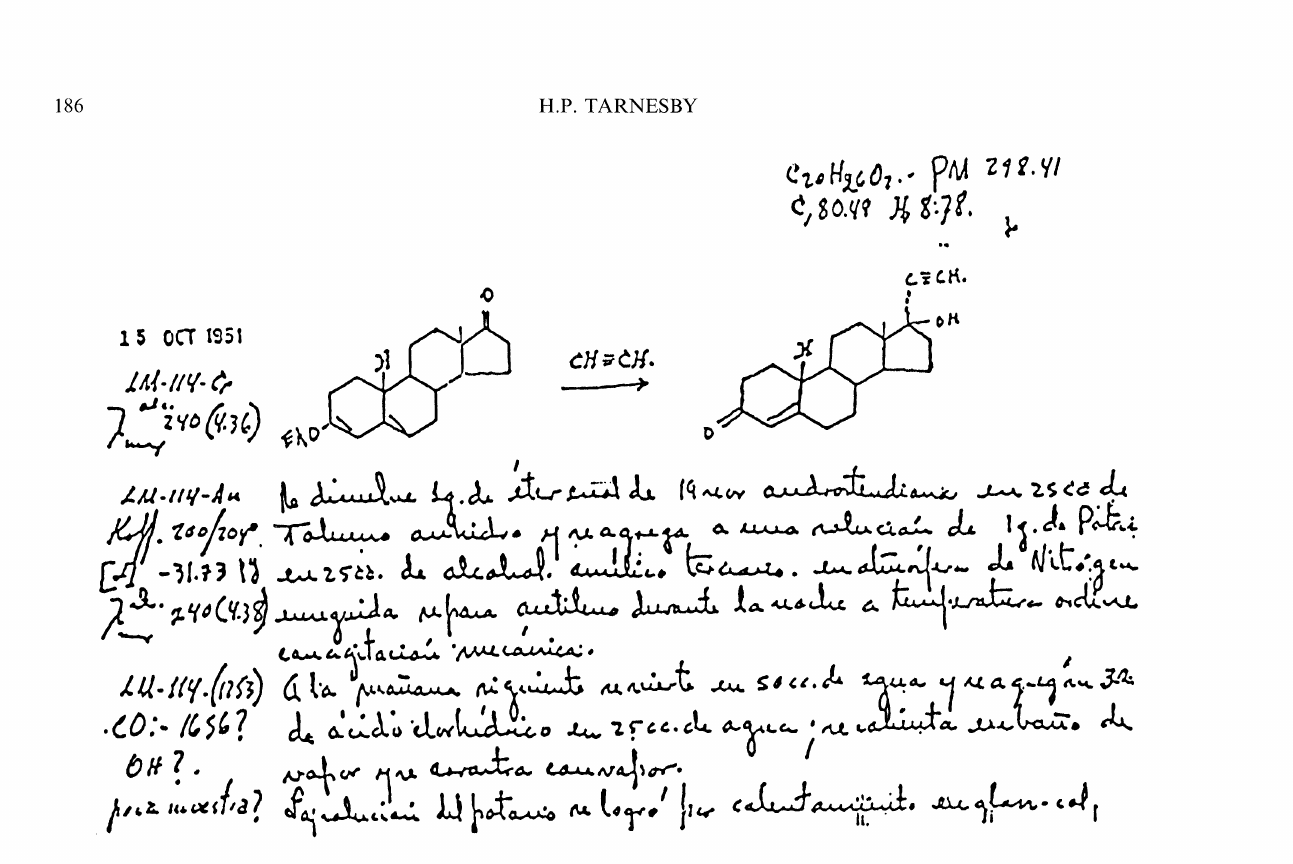
FIGURE The final step in the original synthesis of norethindrone. Facsimile of the record of October 15, 1951, from Djerassi’s laboratory where this synthesis was accomplished. The text describes the overnight (left-hand formula) reaction between enolether of androstenedione and various reagents under continuous mechanical agitation at room temperature. The text then outlines the steps to be taken the next day that are expected to result in synthesis of norethindrone (right-hand formula). (Courtesy of Syntex S.A.,